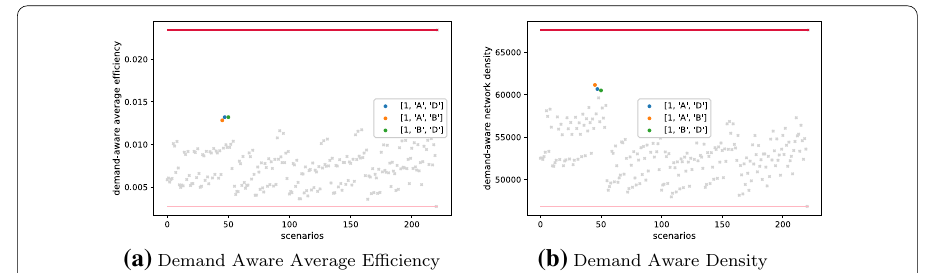
Fig. 11 Global indicators DAAE and (cid:31) DANDC (cid:30) for all the scenarios consisting in adding three new transport mode lines during the “Festival of Lights”